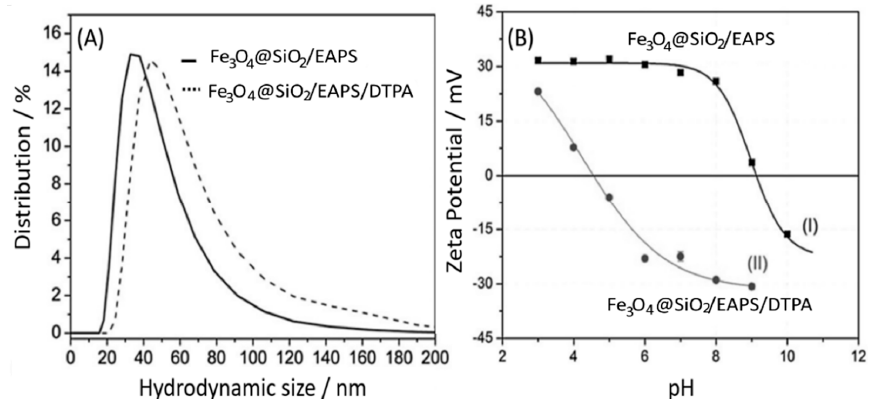
Figure 5. ( A ) Hydrodynamic sizes of the Fe 3 O 4 @SiO 2 /EAPS and of the Fe 3 O 4 @SiO 2 /EAPS/DTPA nanoparticles and ( B ) variation of their corresponding zeta potentials as a function of pH (adapted with permission from [29]).